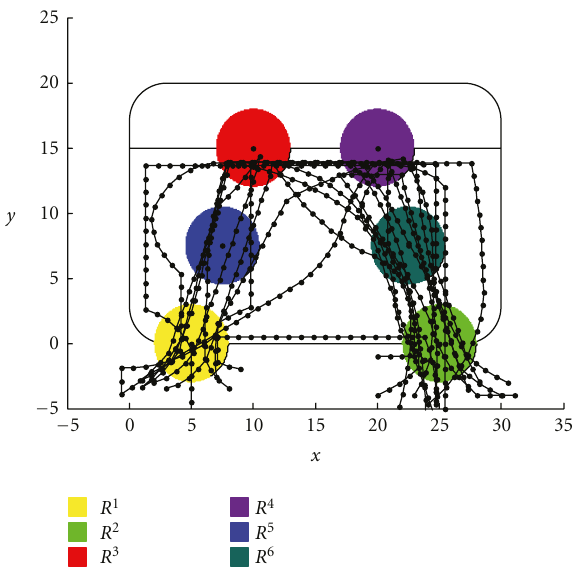
Figure 12: Simulation configuration with the trajectories of ten objects (unit: meter).